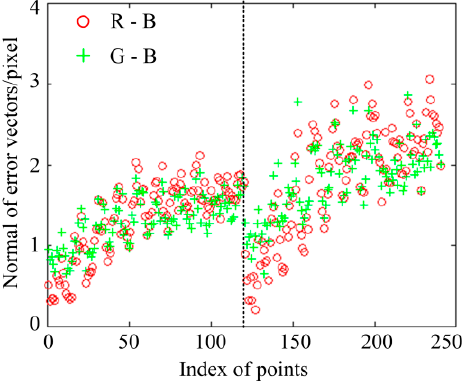
Figure 5. The normal of the distance vectors in tow positions.